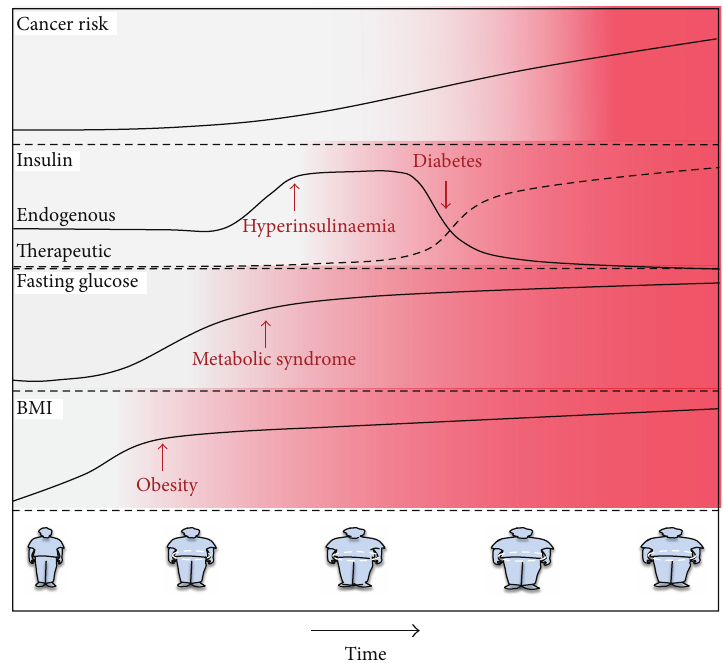
Figure 2: Progression from obesity through metabolic syndrome to diabetes and to increased cancer risk. As an individual’s weight increases, they progress from having a normal weight to being overweight and with time become obese. There is a concomitant increase in high levels of circulating nonesterified fatty acids accompanied by high fasting serum glucose concentrations or hyperglycaemia. Many of these obese individualsexhibitasufficientnumberofthedefiningsymptomstobeclassifiedashavingmetabolicsyndrome.Thehighfastingserumglucose and development of insulin resistance induce chronic secretion of insulin from the pancreas, and the individual manifests hyperinsulinaemia. Eventually, the excessive demands on the pancreas lead to failure of insulin secretion, and diabetes is established. Diabetic therapies stimulate insulin secretion or administer exogenous insulin. Insulin concentrations must reach supraphysiological levels to be effective because of the chronic insulin resistance caused by the continued high concentrations of nonesterified fatty acids released from adipocytes. The combination ofhyperinsulinaemiaandendocrineorparacrinestimulifromadiposetissueincreasestheriskthattheseindividualswilldevelopcertaintypes of cancers.